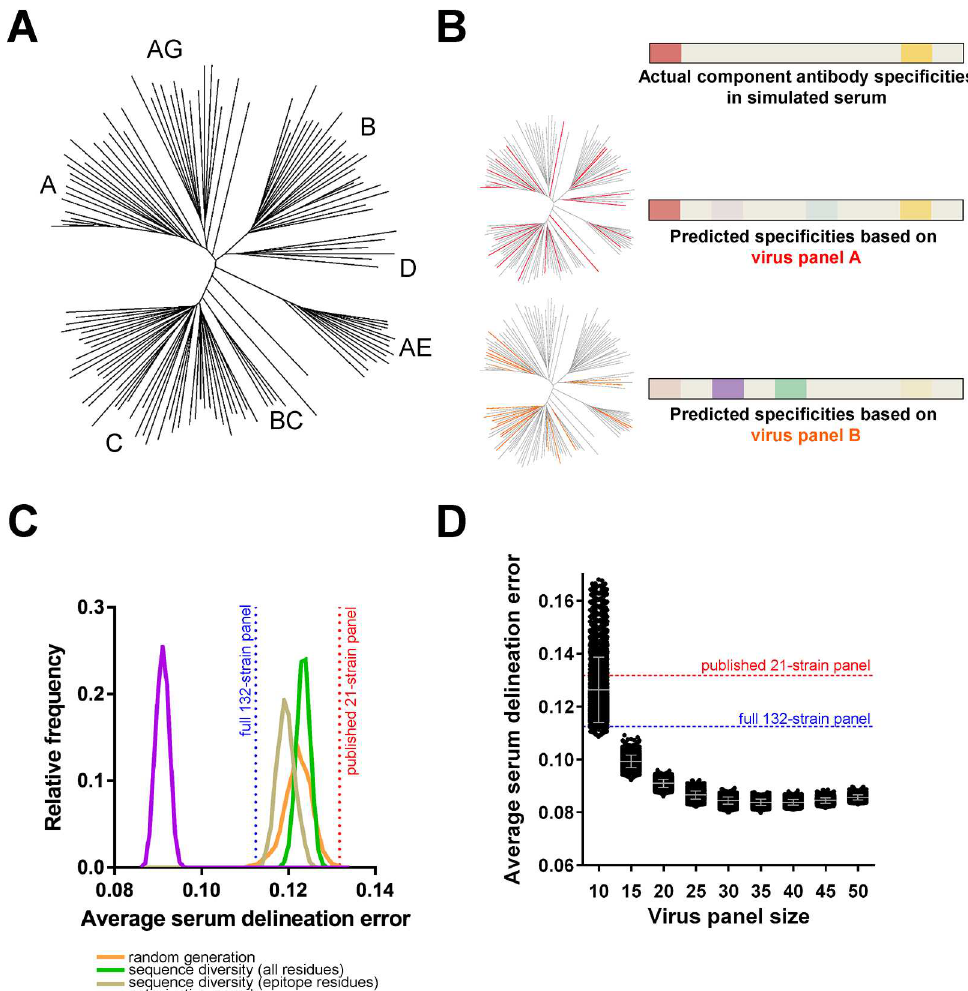
Fig 2. Identification of improved virus panels for NFP analysis. (A) Phylogenetic tree of full set of 132 HIV-1 strains used as a source for virus panel selection.(B) Schematicof virus panel evaluation using simulatedsera. Heatmaps show the relative prevalence of actual or predictedantibodyspecificitiesin a given simulatedserum, highlightingthe increasedaccuracyof NFP predictions when using panel A (red strains) vs. panel B (orange strains). (C) Virus panel search methods using four different approaches(colored curves). For each approach, shown are the relativefrequencies(y-axis) of observingvirus panelsof size 20 with different levels of prediction accuracy(x-axis, averageserum delineation error, computedover a set of simulatedsera for each virus panel). Highlighted are the serum delineationerrors for the published21-strain panel (red) and the full 132-strainpanel (blue). (D) Virus panel size vs. predictionaccuracy. Each dot represents the averageserum delineationerror of a single virus panel, with grey bars representing mean and standarddeviationfor each virus panel size. Shownare the top 5,000 virus panelsfor a search method and panel